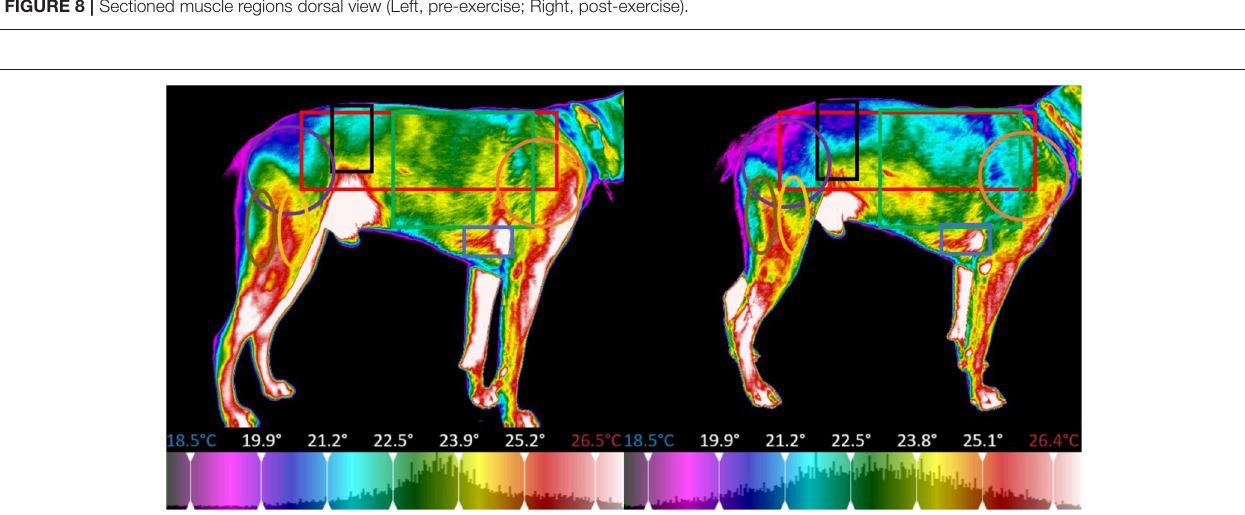
FIGURE 9 | Sectioned muscle regions right lateral view (Left, pre-exercise; Right,